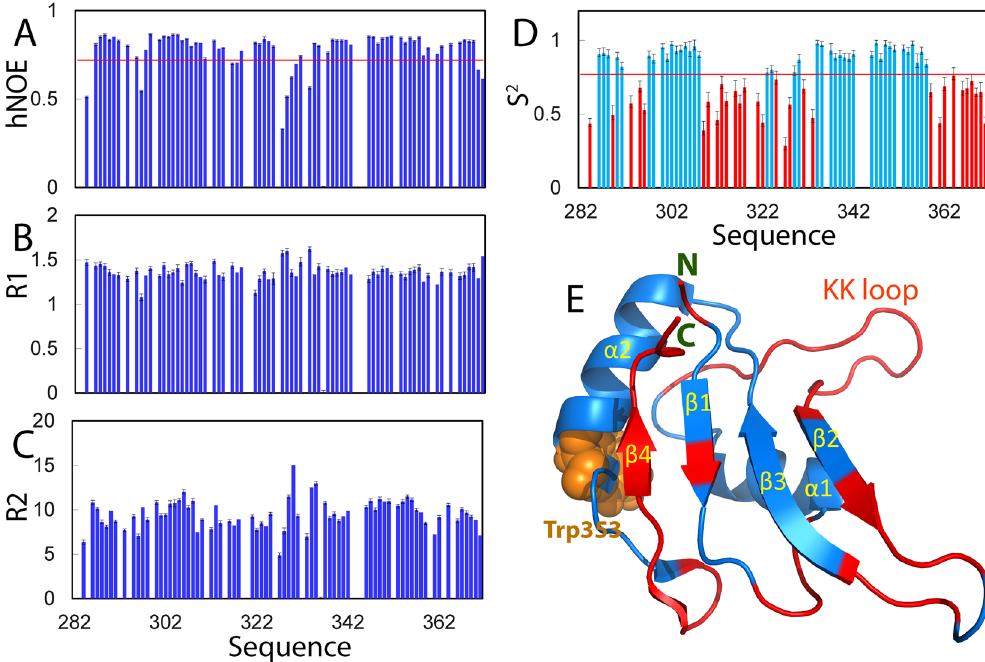
Figure 7. NMR dynamics of the FUS RRM domain. NMR relaxation data of the FUS RRM domain collected at 25 °C at a protein concentration of 400 µ M in 10 mM phosphate buffer at pH 6.8: ( A ) hNOE with the average value of 0.72 displayed as red line; ( B ) R1 and ( C ) R2. ( D ) Generalized squared order parameter (S 2 ) of the FUS RRM domain. Light blue bars indicate residues with S 2 > 0.77 while red bars for residues with S 2 < 0.77 (average value as displayed as red line). ( E ) NMR structure of the FUS RRM domain (pdb ID of 2LCW) with residues having S 2 < 0.77 colored in